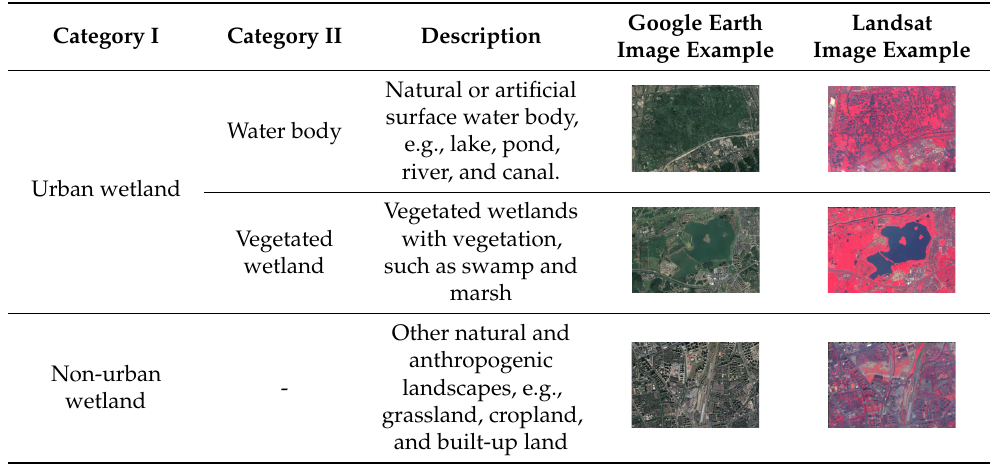
Table 1. The urban wetland classification system used in this study.